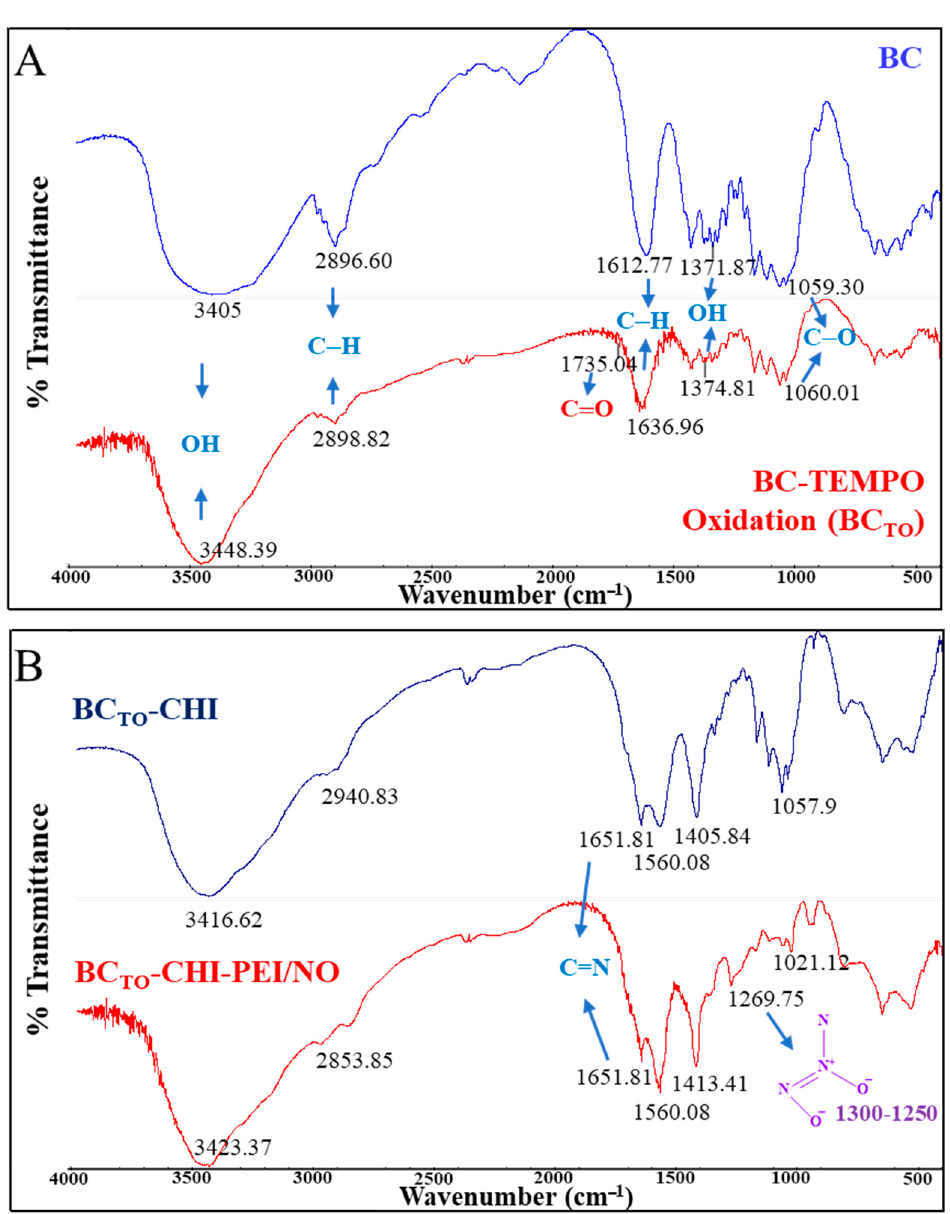
Figure 3. Fourier-transform infrared spectroscopy (FTIR) spectra of ( A ) BC, BC-TEMPO oxidation (BC TO ); and ( B ) BC TO -CHI, BC TO -CHI-PEI/NO hydrogels.